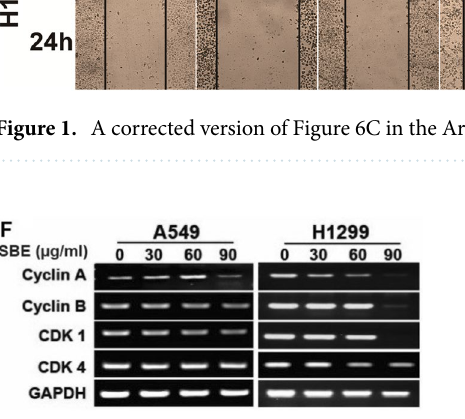
Figure 2. A corrected version of Figure 3F in the